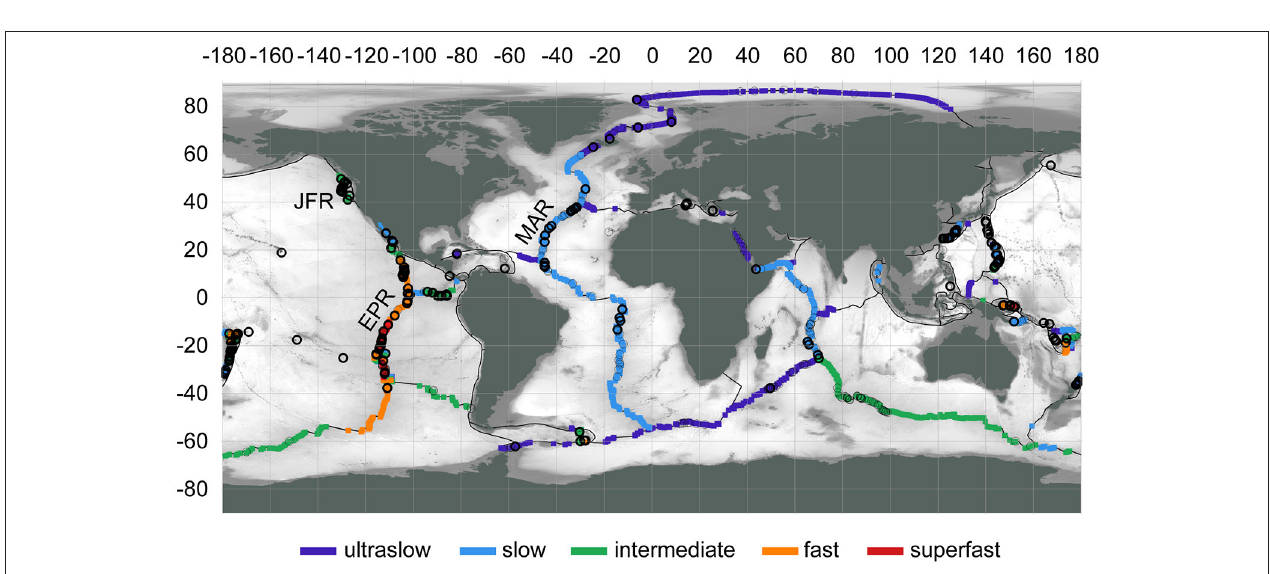
FIGURE 1 | Processes affecting metacommunity dynamics through local controls (influences of habitat and biological interactions), regional controls (larval exchange, connectivity, and gene flow), and disturbance. Examples in parentheses are of specific features, influences, or characteristics.